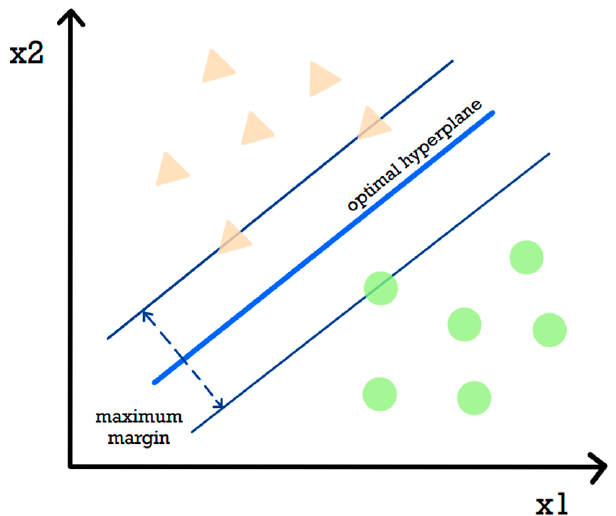
Figure 4. SVM binary classification showing the maximum margin and the optimal